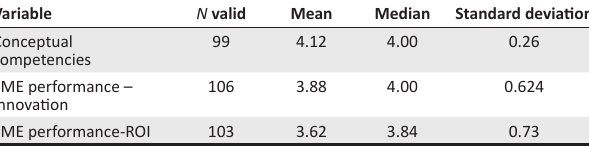
TABLE 4 : Managerial conceptual competencies and firm